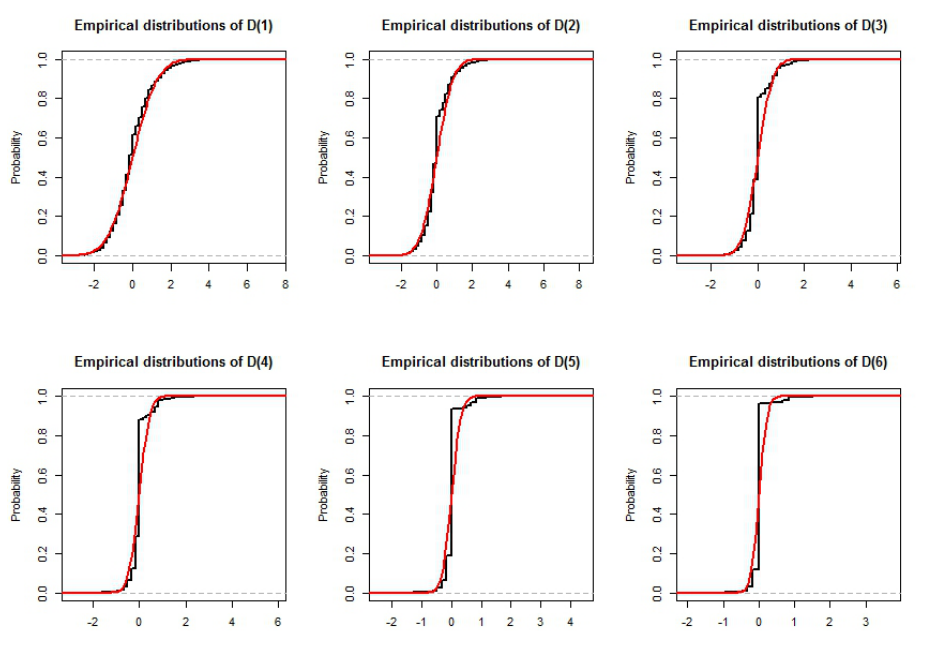
Figure 1. Simulated distribution of the D ( i ) , i = 1,...,6 for a process of length n = 15. A normal distribution with mean 0 and variance set at the value calculated in Section 3 is plotted in